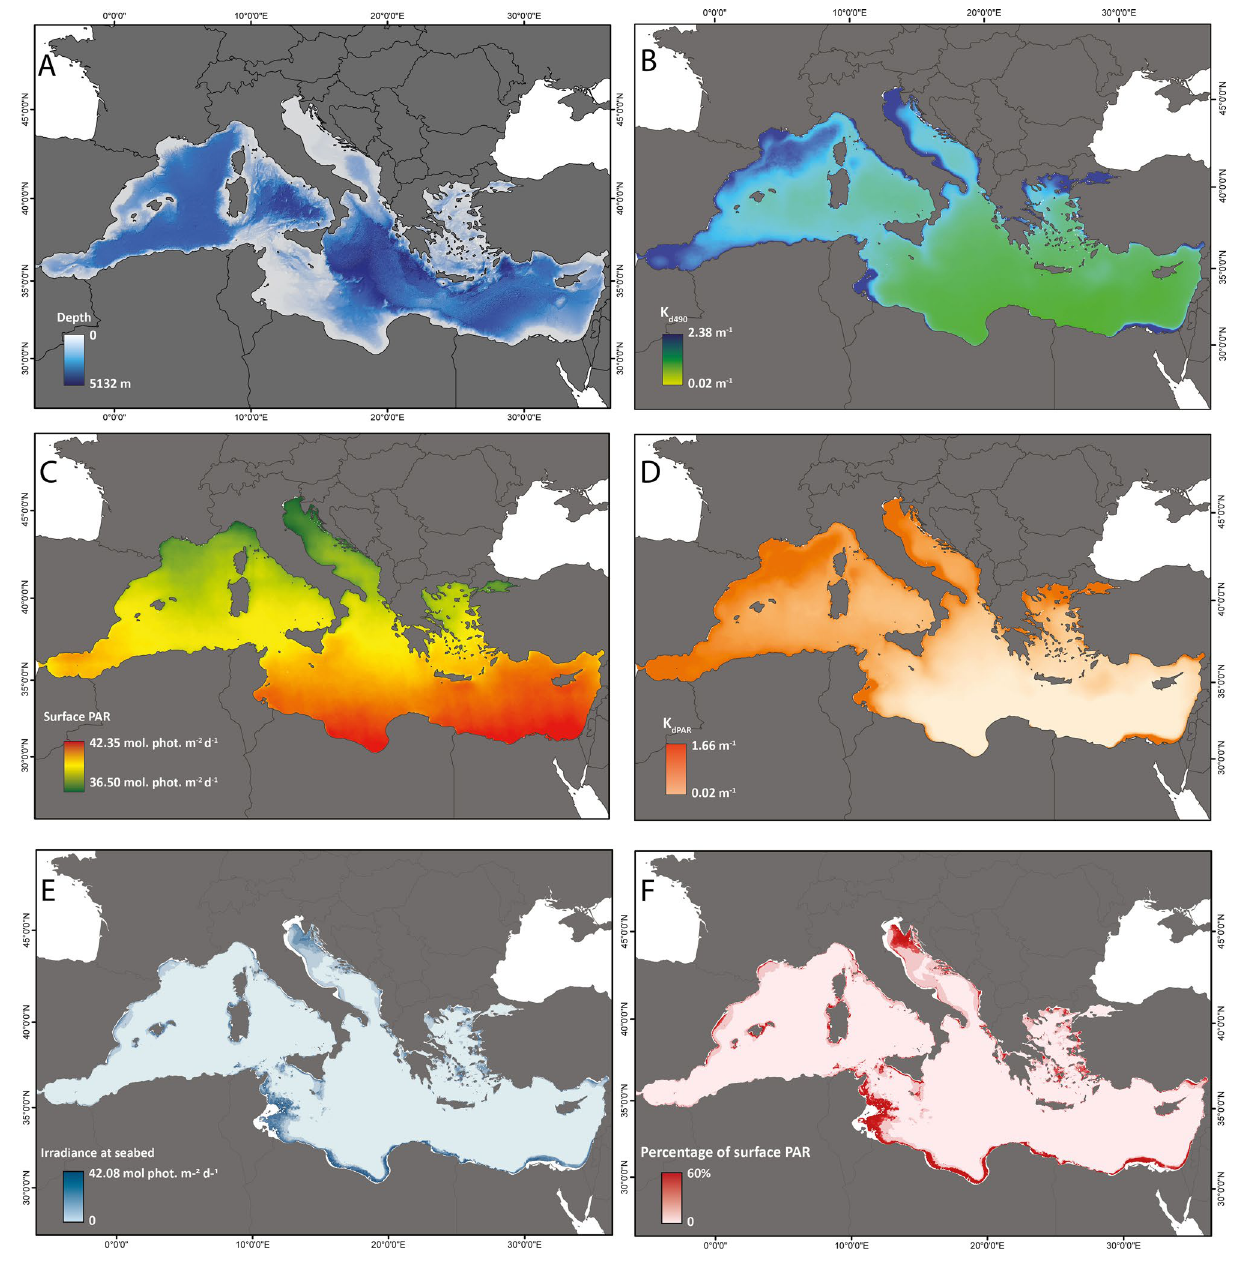
Figure 1. Bathymetry, satellite data and estimated light at seabed. ( A ) Bathymetric data for the Mediterranean Sea; ( B ) diffuse attenuation coefficient at 490 nm from satellite data in the Mediterranean Sea (K d490 ); ( C ) Surface Photosynthetically Active Radiation (PAR); ( D ) Diffuse attenuation coefficient for PAR light (K dPAR ) calculated from K d490 , according to method proposed by 59 and 66 ; ( E ) Quantity and ( F ) Fraction of surface PAR reaching the seabed for the Mediterranean Sea. Data were sourced from the NASA Ocean Color database (https:// ocean color. gsfc. nasa. gov/). Maps were generated using ArcMap 10.5 software (© ESRI, https:// deskt op. arcgis.